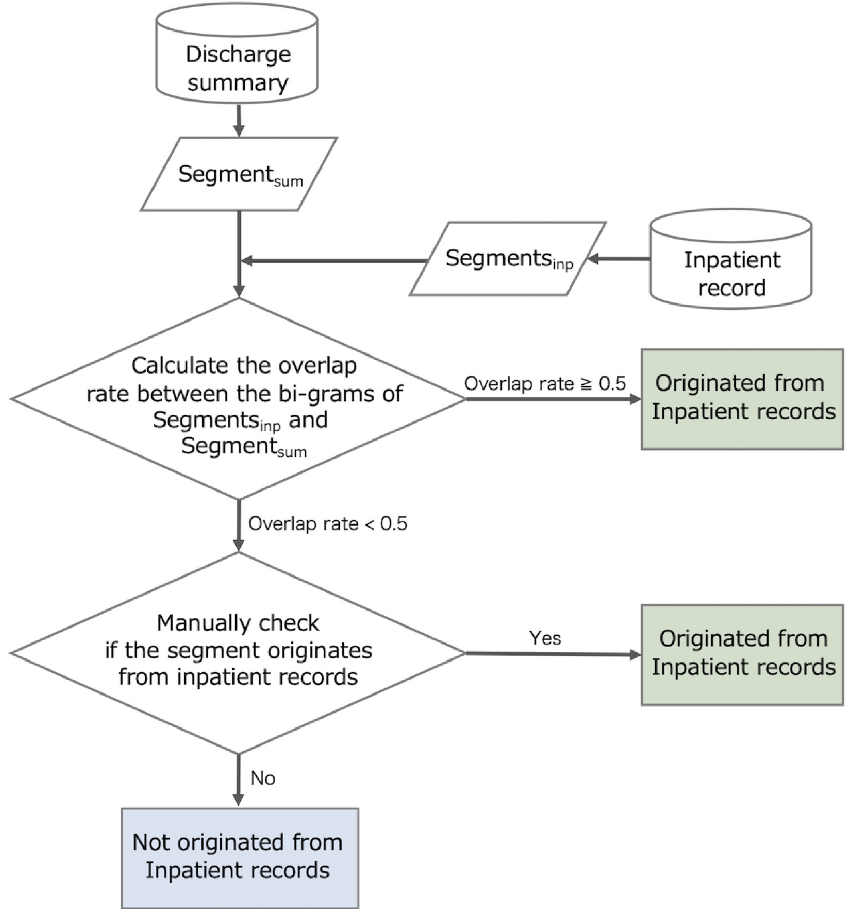
Fig 3. Our annotation flowchart of the source origin. The source origin is manually determined in two steps using pre-filtering.